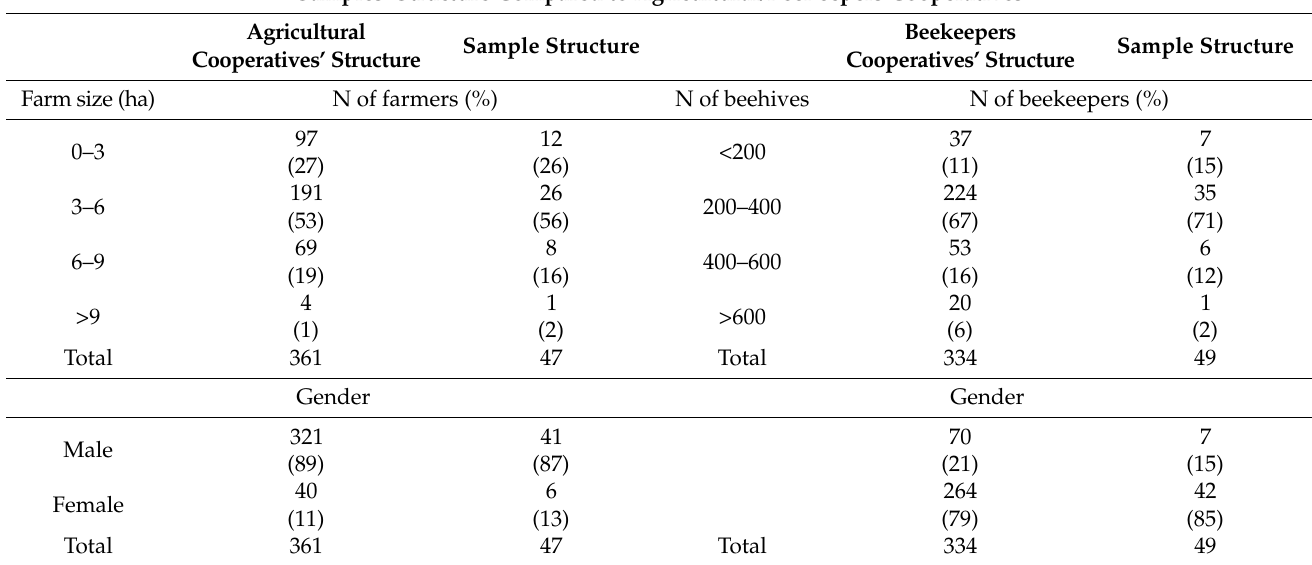
Table 1. Samples’ characteristics compared to agricultural/beekeepers cooperatives structure. Samples’ Structure Compared to Agricultural/Beekeepers Cooperatives Agricultural Cooperatives’